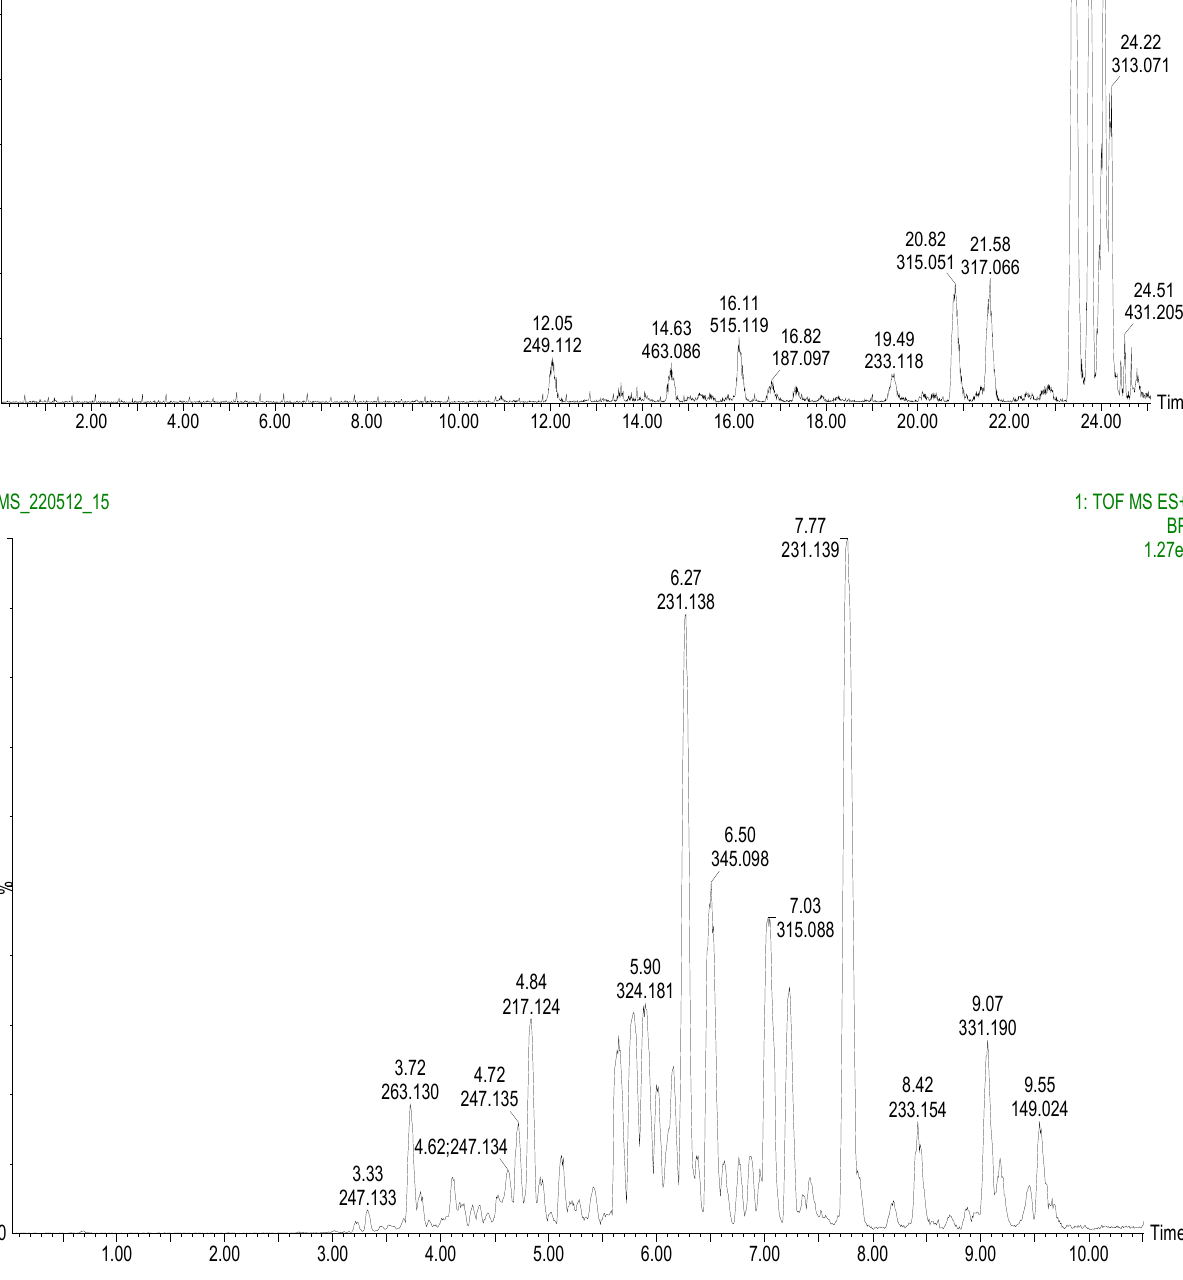
Figure 2. UHPLC-ESI-MS base peak chromatogram for the chloroform extract of E. africanus ’s negative and positive ion modes.